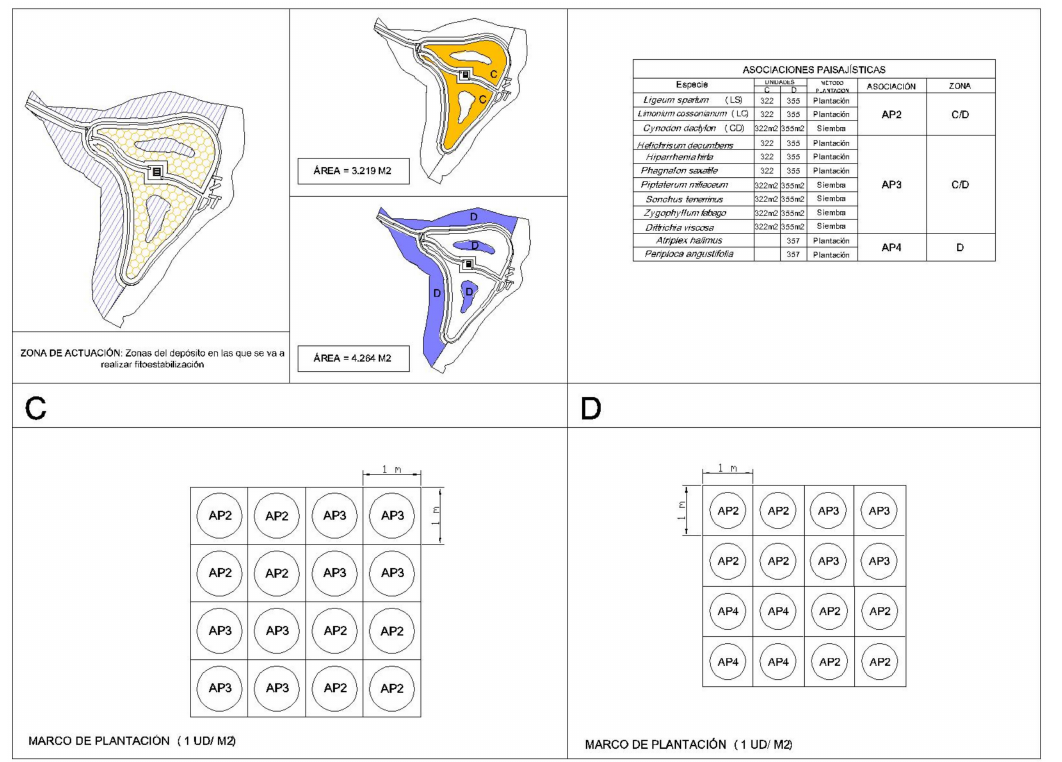
Figure A8. Planting map for zones C and D of Case Study 1.